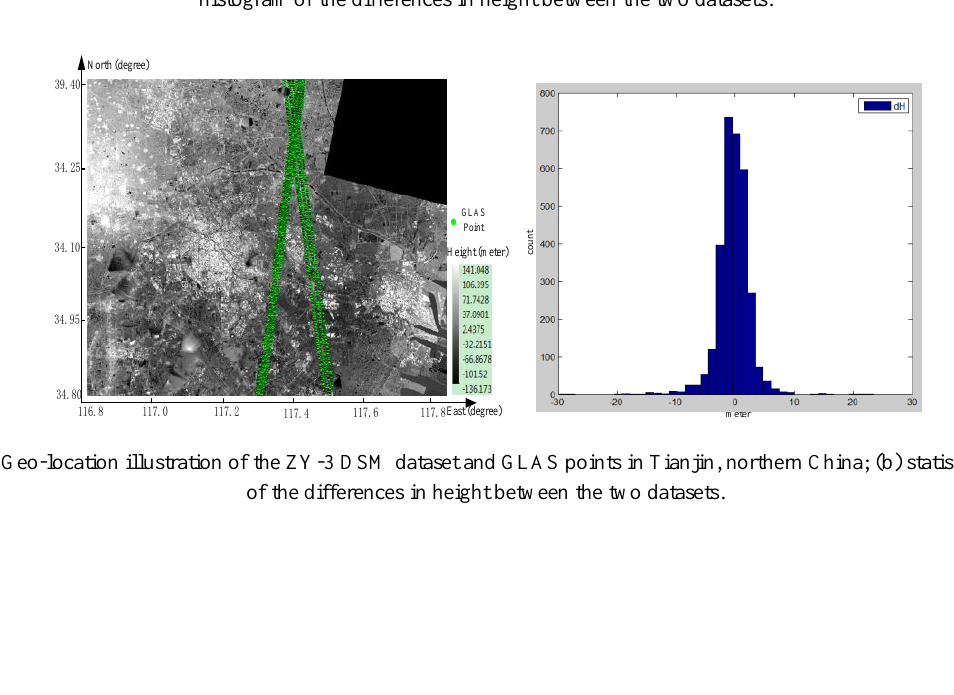
Figure 2. (a) Geo-location illustration of the ZY-3 DSM dataset and GLAS points in Lianyungang, eastern China; (b) statistical histogram of the differences in height between the two datasets.